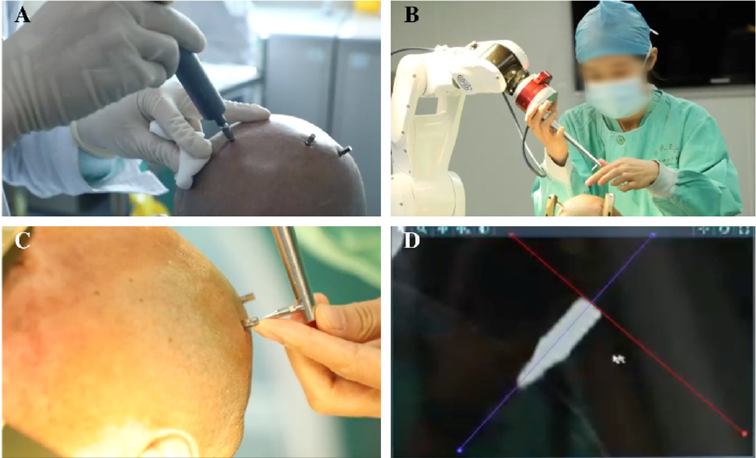
Figure 2. Implanting bone screws and frameless registration. ( A ) Bone screws were implanted under local anesthesia. ( B – D ) Frameless registration by the mechanical contact of the tip of the robot probe with bone screw markers.